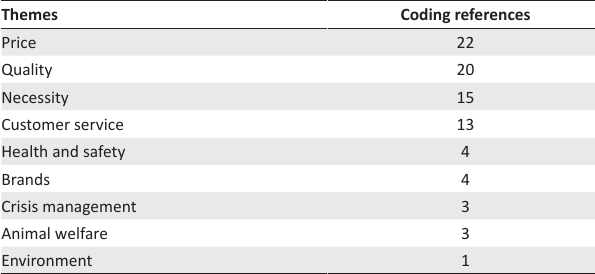
TABLE 6: Coding references for other-than-corporate social performance aspects that affect purchasing